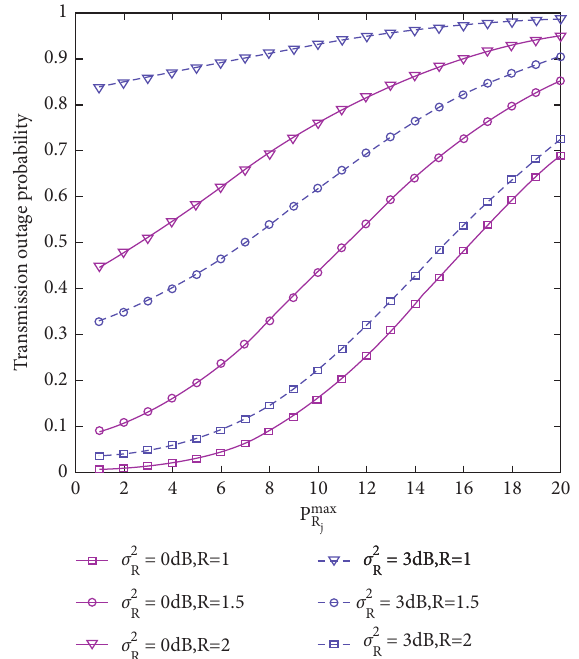
Figure 2: Transmission outage probability versus P max ferent value of σ 2 R and R , where P A � 10 dB , N R � 5, and ϕ � 0 . 5.